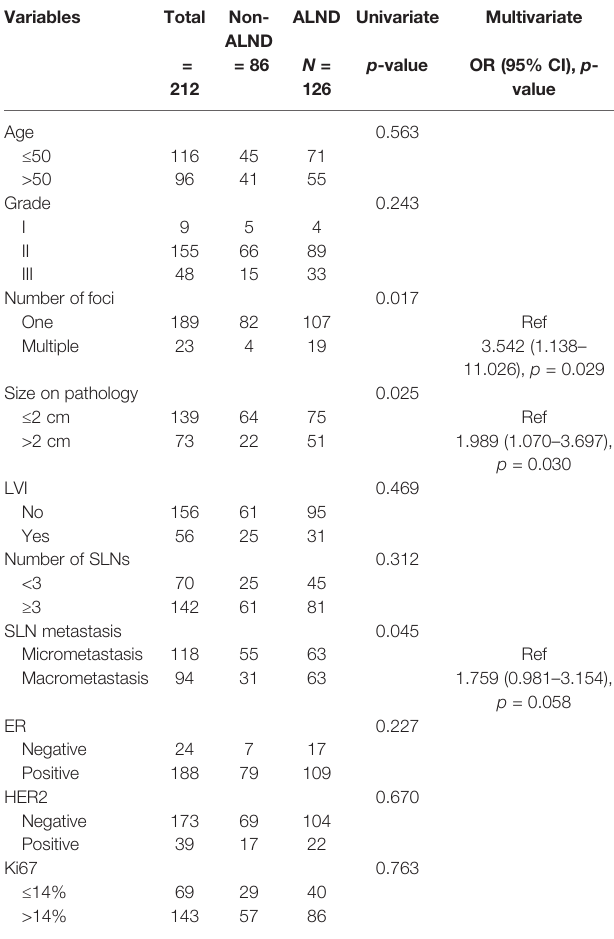
TABLE 1 | Baseline characteristics of clinicopathological factors in cN0 patients who received mastectomy and had false-negative FS in SLNB. Variables Total Non- ALND Univariate ALND